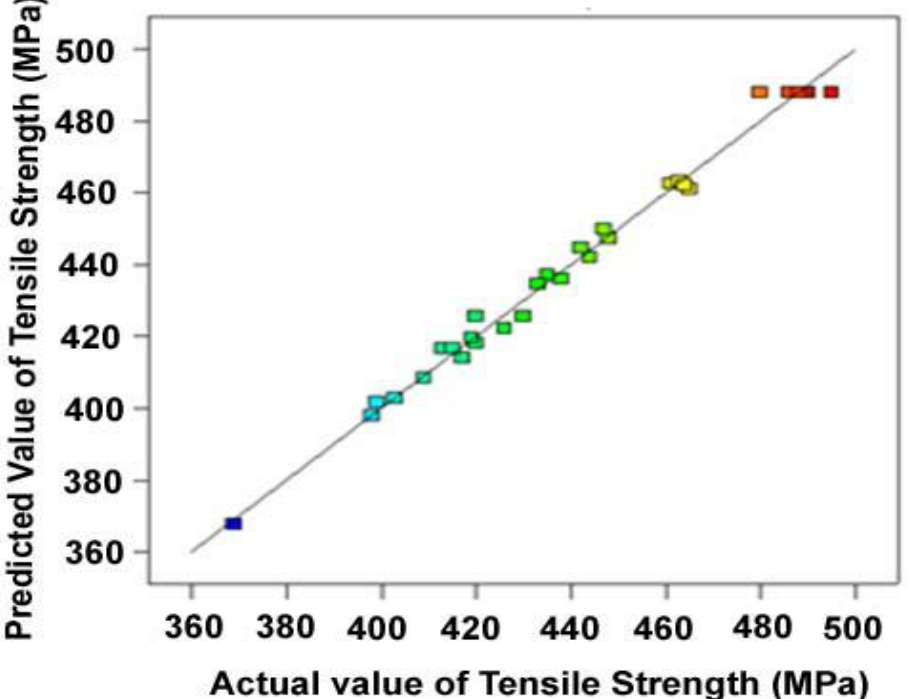
Figure 2. Correlation graph.